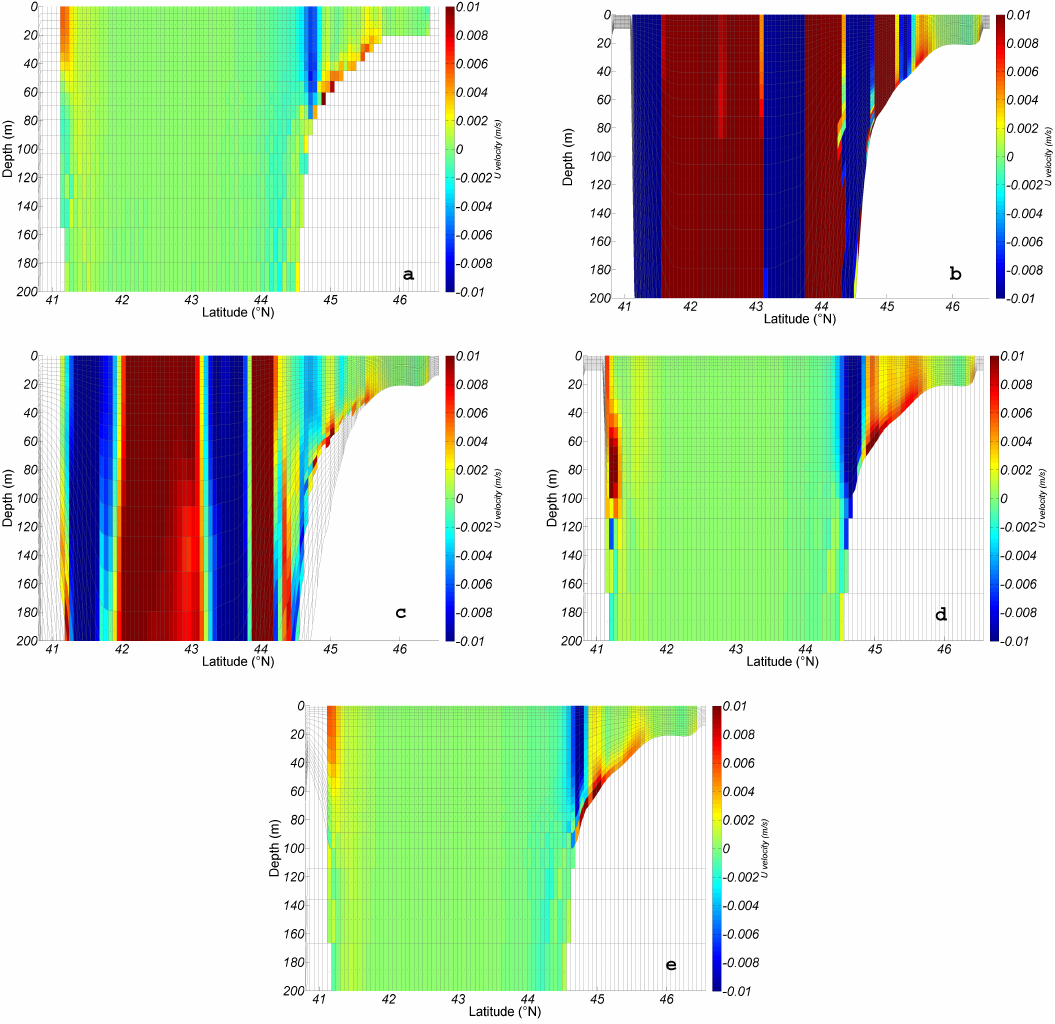
Fig. 4. Spurious zonal velocities along 31 ◦ E after 3.5months of simulation: (a) ZCO; (b) SCO; (c) Z*SIG; (d) SZH; (e) SZHENV.